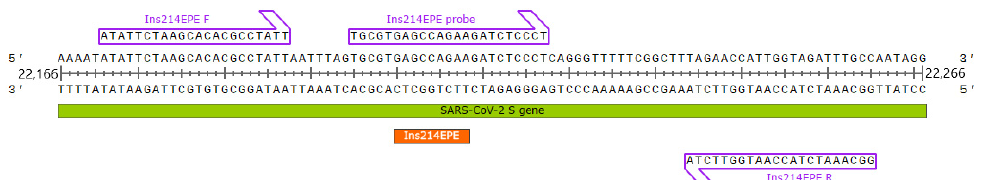
Figure 2. Ins214EPE oligonucleotides binding scheme.